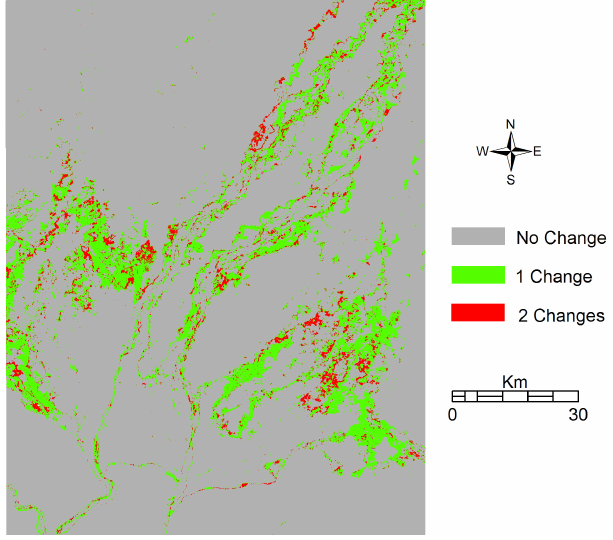
Figure 6. Average annual temperature (a) and precipitation (b) in the Hotan Oasis. Runoff of Hotan River (c) , water consumption and area change of cultivated land in the Hotan Oasis (d) .